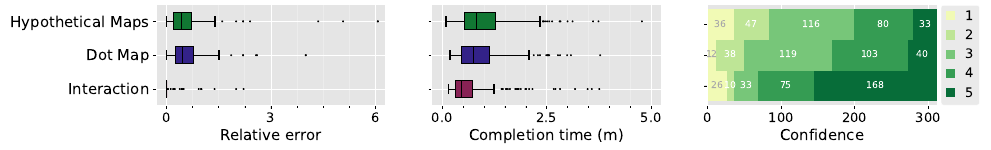
Figure 6. Results of the compare distributions task.